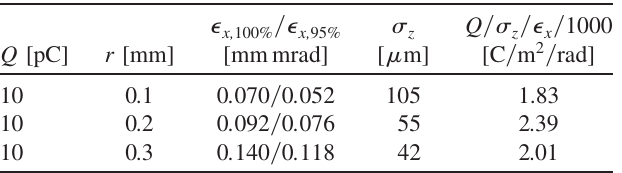
LOW-CHARGE, HARD X-RAY FREE ELECTRON LASER . . TABLE II. ASTRA simulation results, optimized for 3 different initial laser profiles.